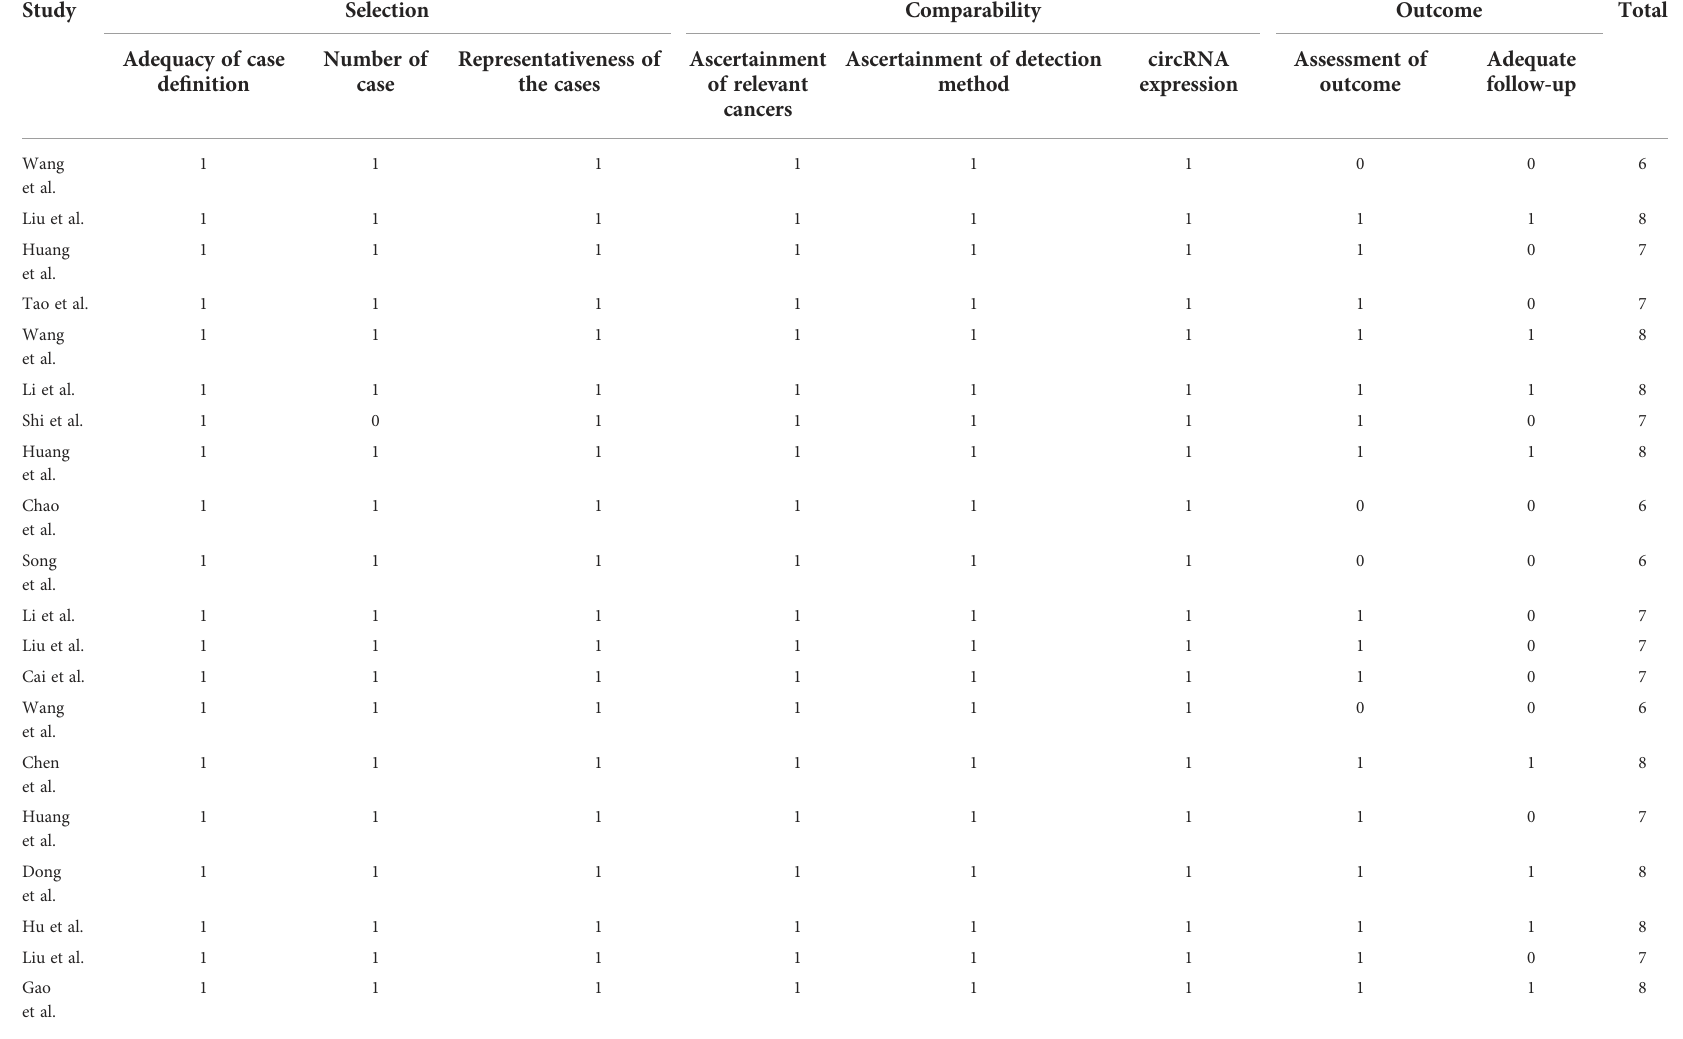
TABLE 4 Quality assessment of eligible studies for clinical parameter analysis and prognosis analysis according to the Newcastle-Ottawa